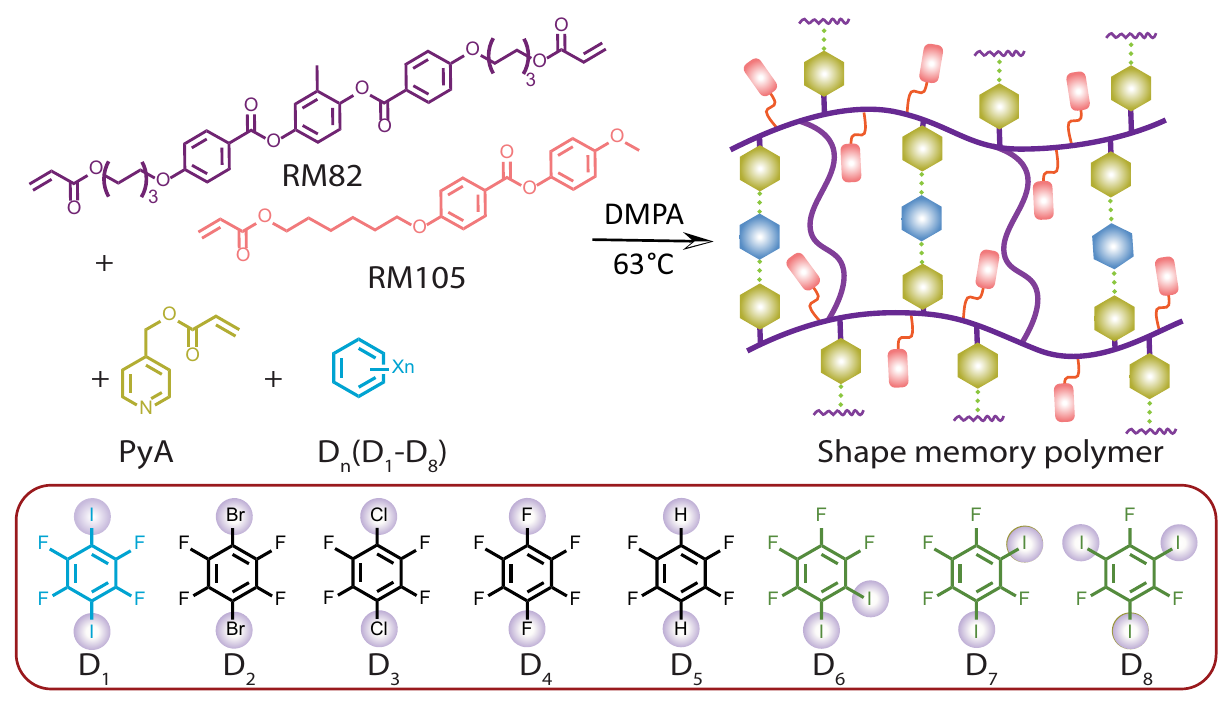
Fig. 2 | Chemical structures of shape memory polymers based on halogen bonds. Top: Synthesis route and proposed halogen-bonded shape memory